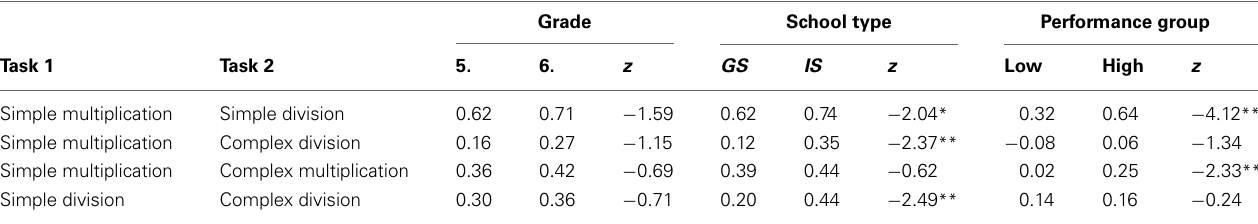
Table 3 | Partial correlations (controlling for non-verbal intelligence, verbal short-term memory and performance in solving addition and subtraction tasks) between arithmetic tasks separately for fifth and sixth grades, general (GS) and intermediate (IS) secondary schools and low-skilled and high-skilled